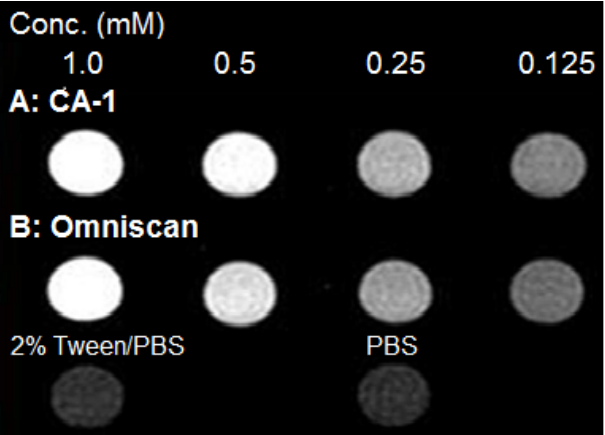
Figure 5. T1-weighted MRI images of CA-1 and Omniscan at 7 T and 25 °C in PBS at different Gd 3+